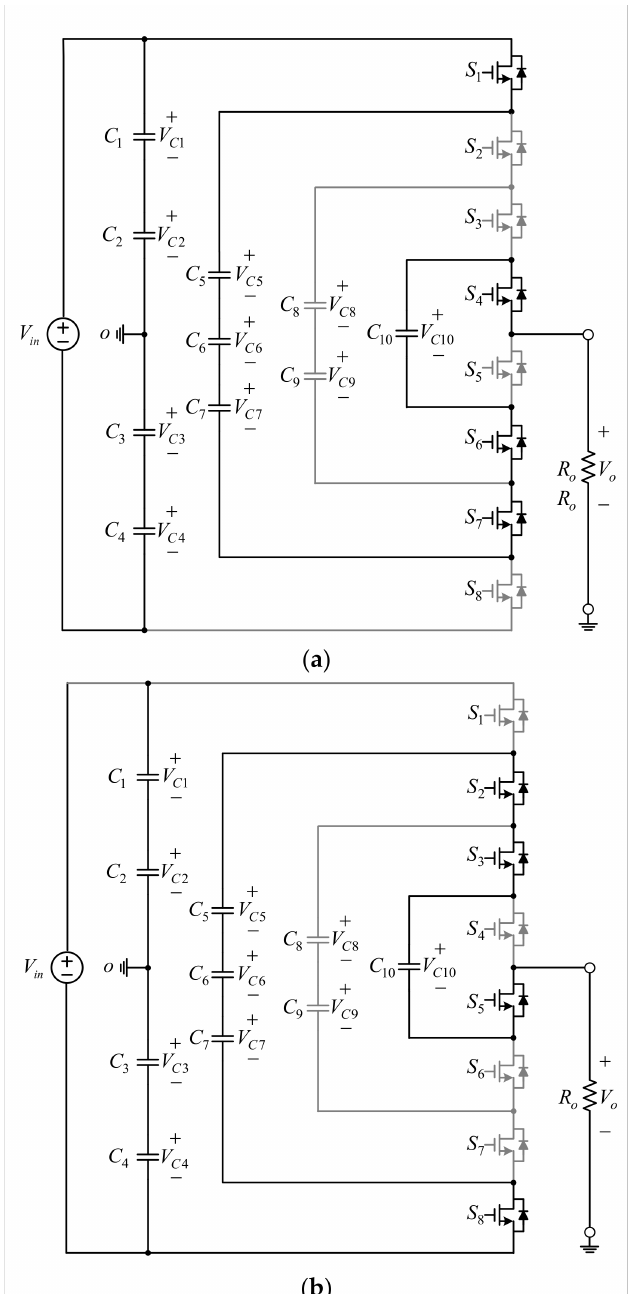
Figure 7. ( a ) one zero voltage output; ( b ) the other zero voltage output of a five-level flywheel capacitor